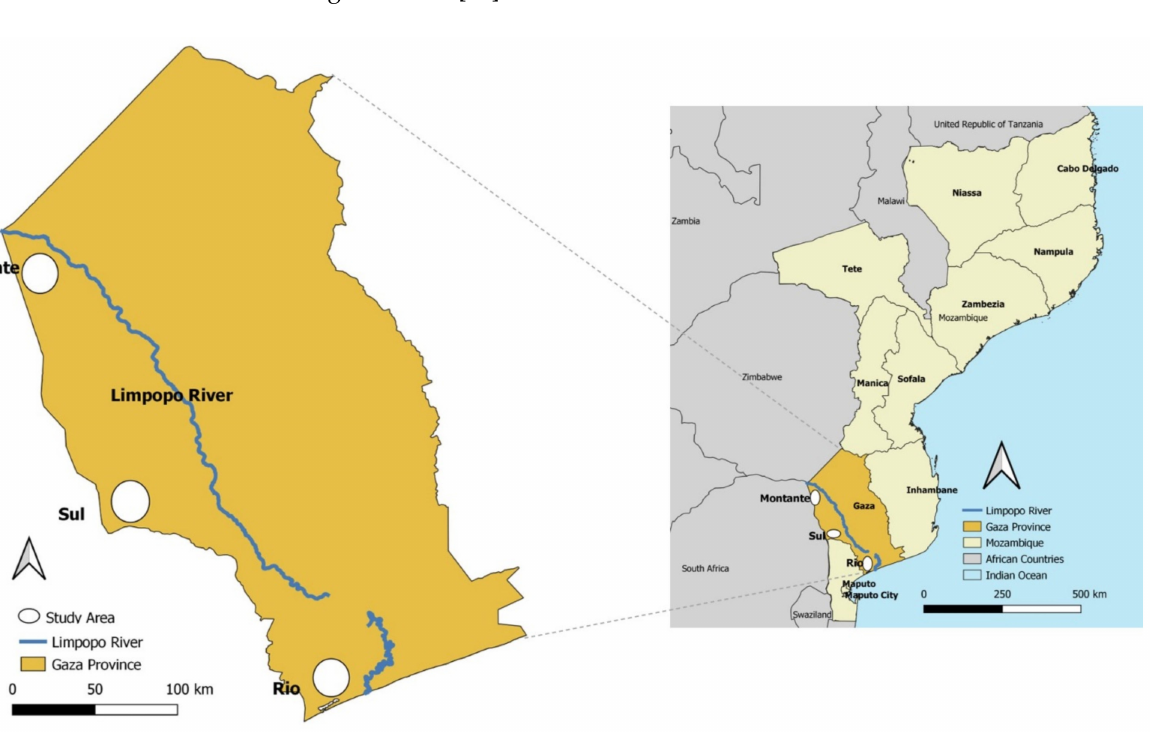
Figure 1. The location of the Chokwe Irrigation Scheme